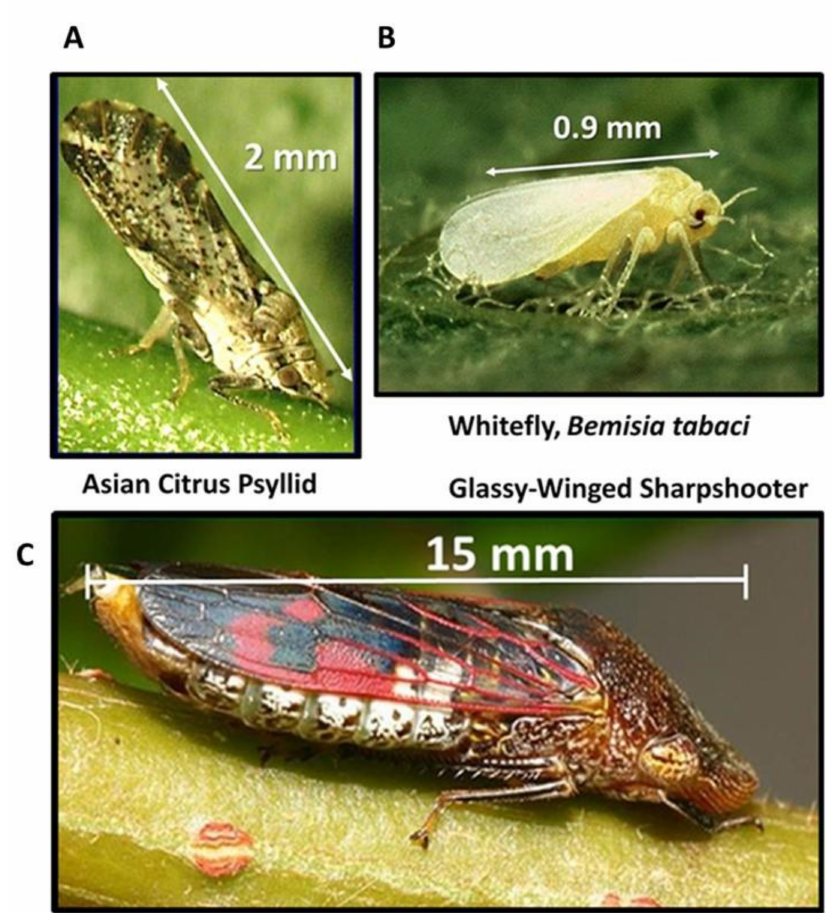
Figure 1. Hemipteran Insect Vectors of Crop Pandemics. ( A ) Asian citrus psyllid, Diaphorina citri Kuwayama, 1908 (Liviidae) (https://www.cabi.org/isc/datasheet/18615, accessed 15 July 2021); ( B ) Silverleaf Whitefly, Bemisia tabaci (Gennadius, 1889) MEAMI, (Aleyroididae) (https://www. cabi.org/isc/datasheet/8925, accessed 15 July 2021); ( C ) Glassy-winged Sharpshooter Leafhopper, Homalodisca vitripennis (Germar, 1821) (Cicadellidae) (https://www.cabi.org/isc/datasheet/27561# todescription, accessed 15 July 2021) (Figure S1. Global Distribution Maps, Supplemental